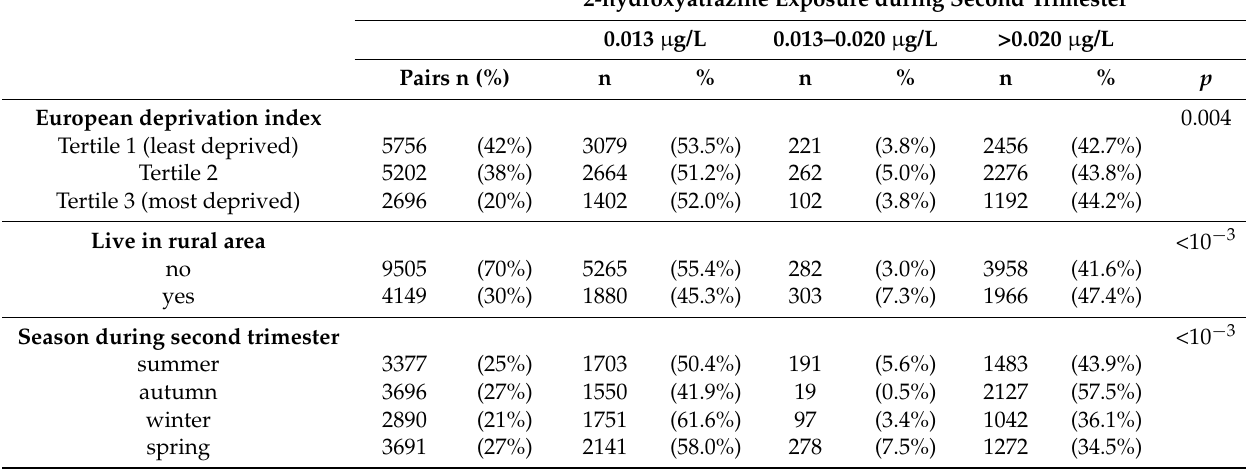
Table 2. Relation between exposure to 2-hydroxyatrazine during second trimester of pregnancy and European deprivation index. Univariable analysis, Deux-Sèvres, France, 2005–2010. n = 13,654 mother/neonate pairs and 279